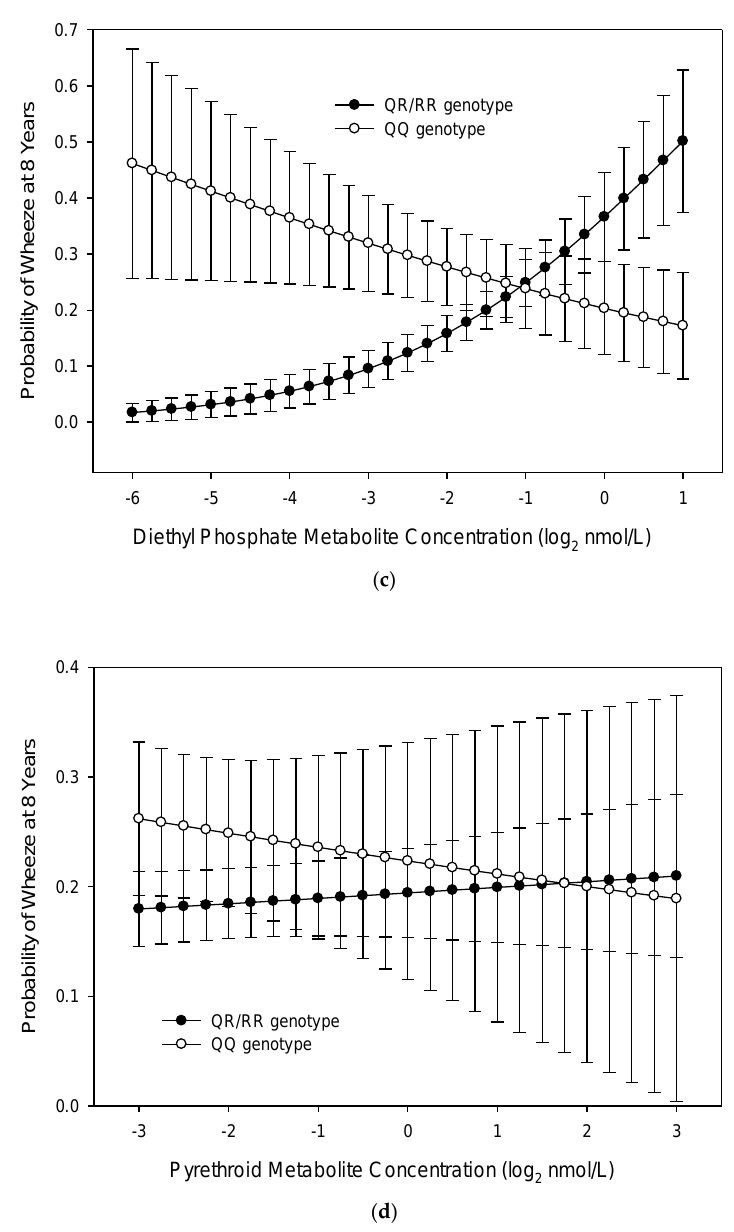
Figure 3. Probability of child wheeze at age 8 years related to maternal PON1 192 genotype and maternal ( a ) dimethyl phosphate (DM) metabolite concentration, ( b ) dialkyl phosphate (DAP) metabolite concentration, ( c ) diethyl phosphate (DE) metabolite concentration, and ( d ) pyrethroid (3-Phenoxybenzoic acid, 3PBA) metabolite concentration during gestation ( n = 224).